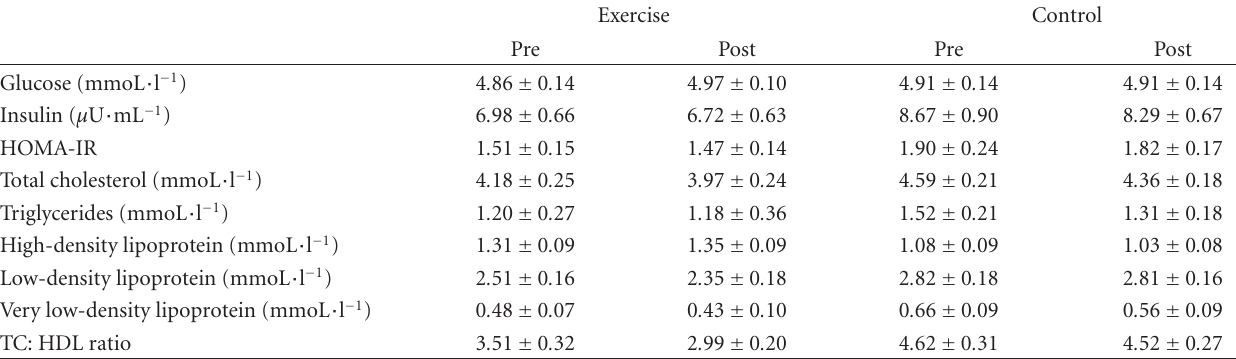
Table 4: Glucose, insulin, HOMA-IR, and lipid change for the high-intensity intermittent exercise and no exercise control groups ( N = 38; mean and standard